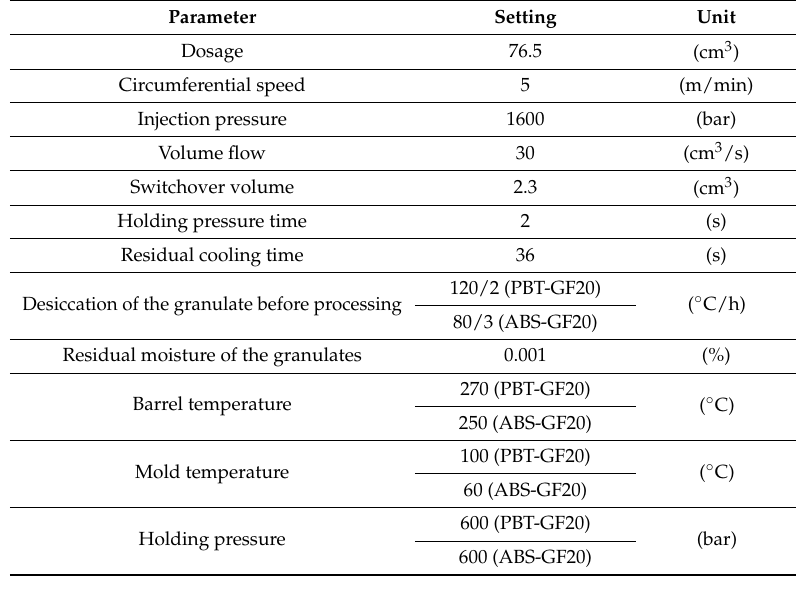
Table 7. Constant adjusted processing parameters to process the specimen in the injection molding process.